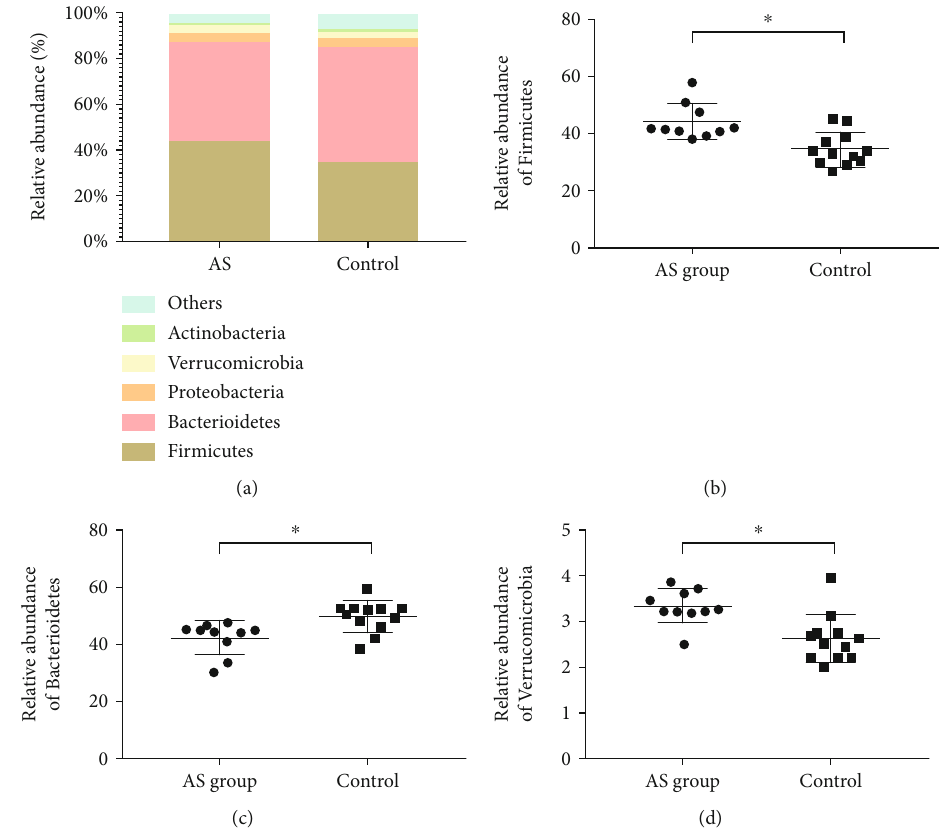
Figure 3: Phylum-level examination of microbiome composition. (a) The relative abundance of fecal microbes at the phylum level. Intergroup comparison of relative abundance of (b) Bacteroidetes, (c) Firmicutes, and (d) Verrucomicrobia. ∗ P < 0 : 05 (Figure 5(a)) and Verrucomicrobia (Figure 5(c)) with ESR at phylum level and direct correlation between Bacteroides (Figure 5(d)) and ESR, but inverse correlation of Ruminococ- cus (Figure 5(e)) and Parasutterella (Figure 5(f)) with ESR at genus level.